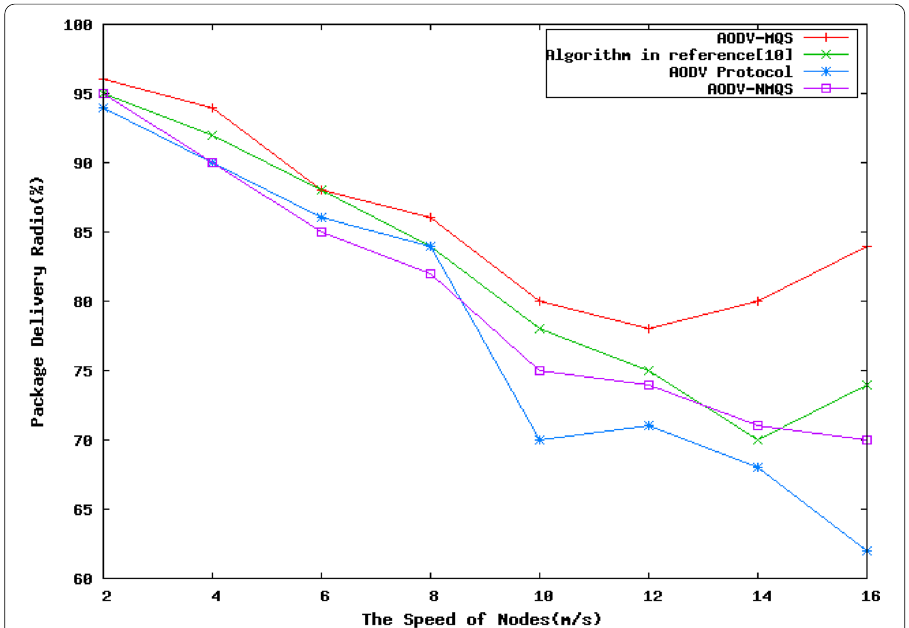
Fig. 9 Comparison of delivery ratio of four routing algorithms in an unsafe environment